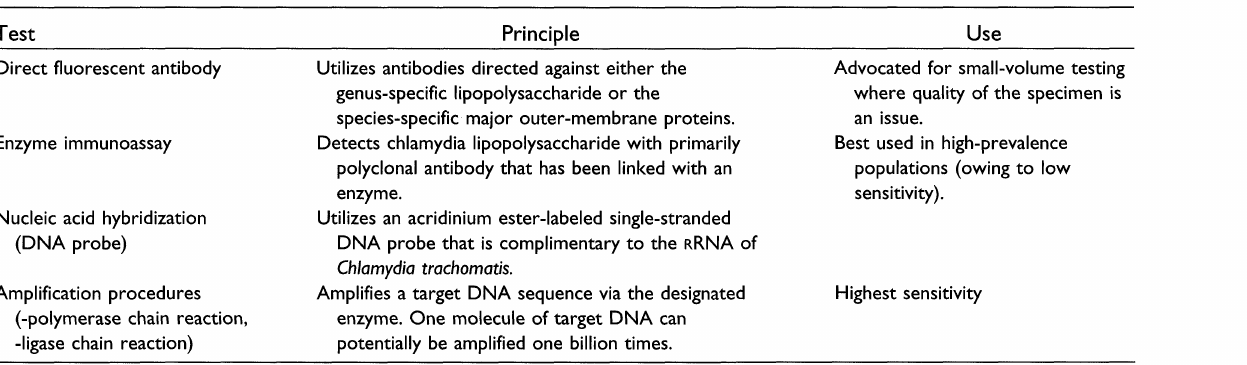
TABLE I. Non-culture tests for the detection of Chlamydia